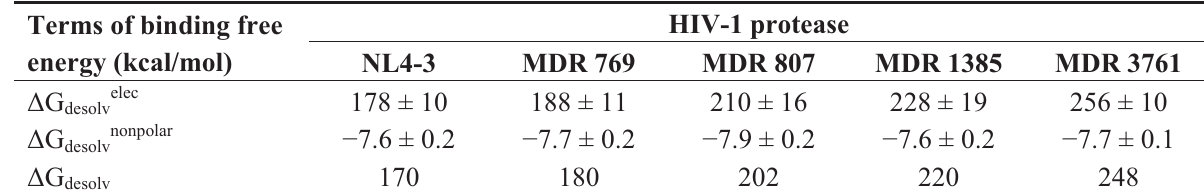
Table 3. Energy analysis of the HIV-1 protease-p2/NC complex.